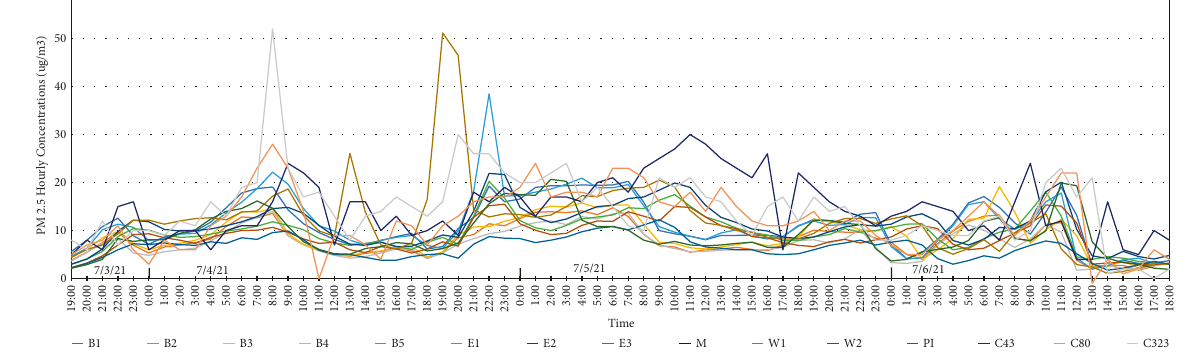
Figure 2: Time series of PM 2.5 concentrations ( µ g/m3) at the study locations and the CAMS sites. Table 1: Basic statistics of hourly PM 2.5 concentrations during the study period at the various study locations and the CAMS sites. Date Sites B1 B2